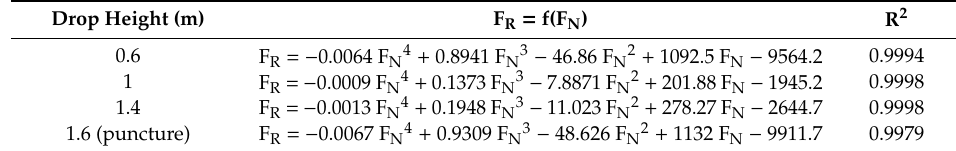
Table 10. Correlation between the impact force F R and the tensile force F N for the drop hammer weight of 100